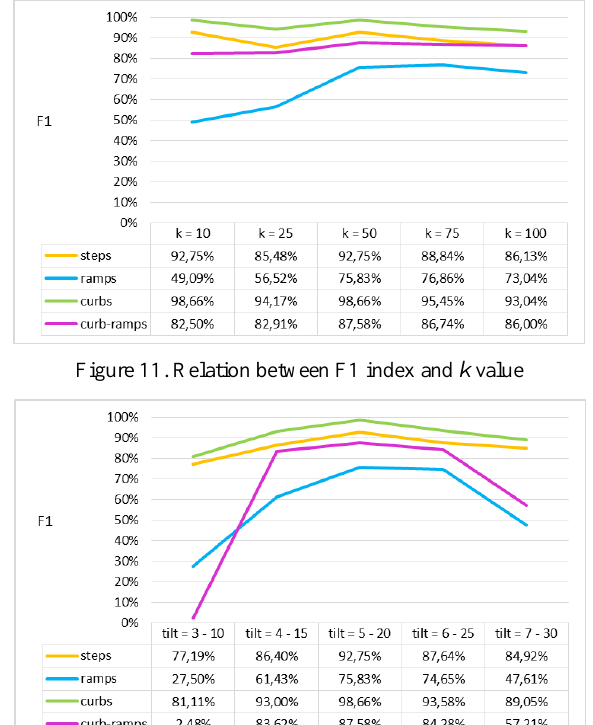
Figure 12. Relation between F1 index and bidirectional tilt ranges